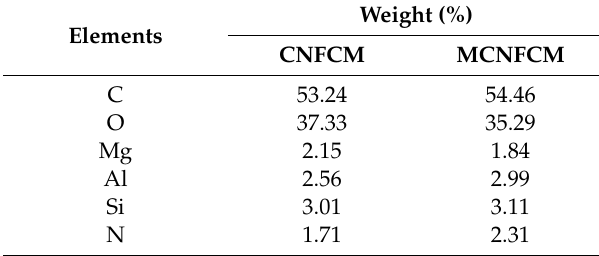
Table 6. EDX analysis of CNF-coated monolith and the modified CNF-coated